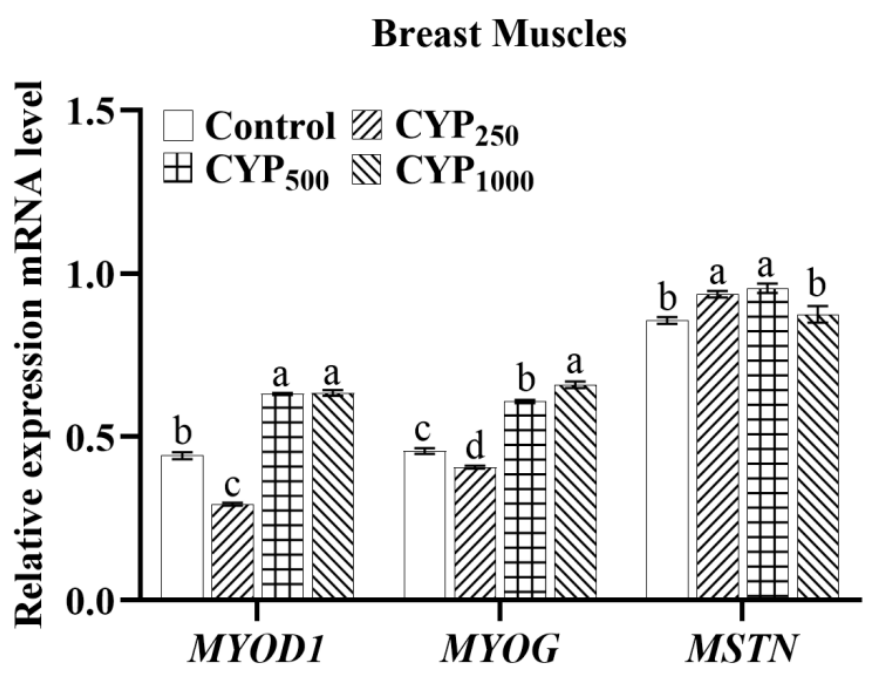
Figure 2. The MYOD1 , MYOG , and MSTN mRNA expressions of breast muscle in broilers. Different lowercase superscripts indicate significant differences ( p < 0.05). MYOD1 , myogenic differentiation 1; MYOG , myogenin; and MSTN , myostatin.